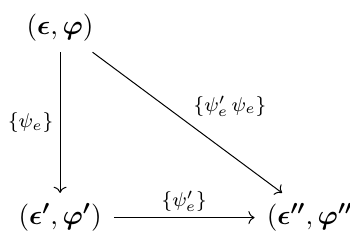
Figure 14 . Edge transformation { ψ e } followed by { ψ 0